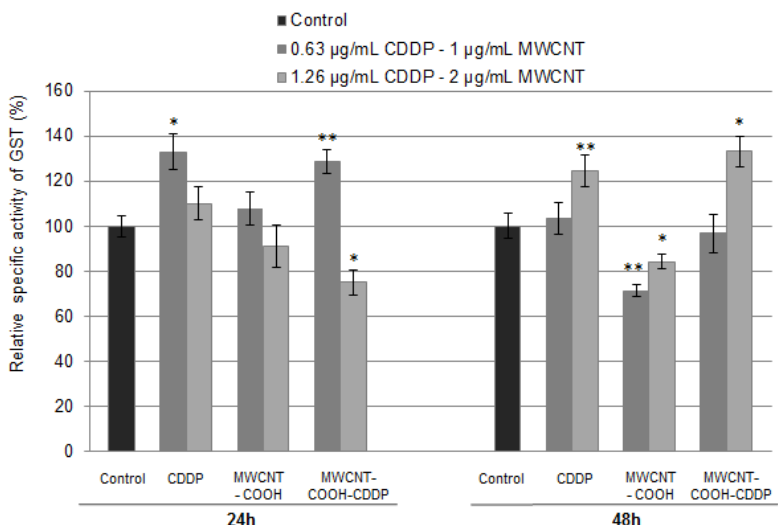
Figure 11. Relative specific activity of GST after MDA-MB-231 cells exposure to MWCNTs (1, 2 µg/mL) and CDDP (0.63, 1.26 µg/mL) for 24 h and 48 h. The results are calculated as the mean ± SD of 3 replicates and represented relative to control. * p < 0.05, ** p < 0.01 vs. control.